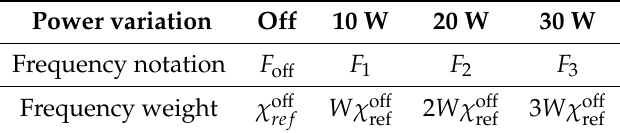
Table 2. Frequency notation and frequency weight for each power variation—linear model.